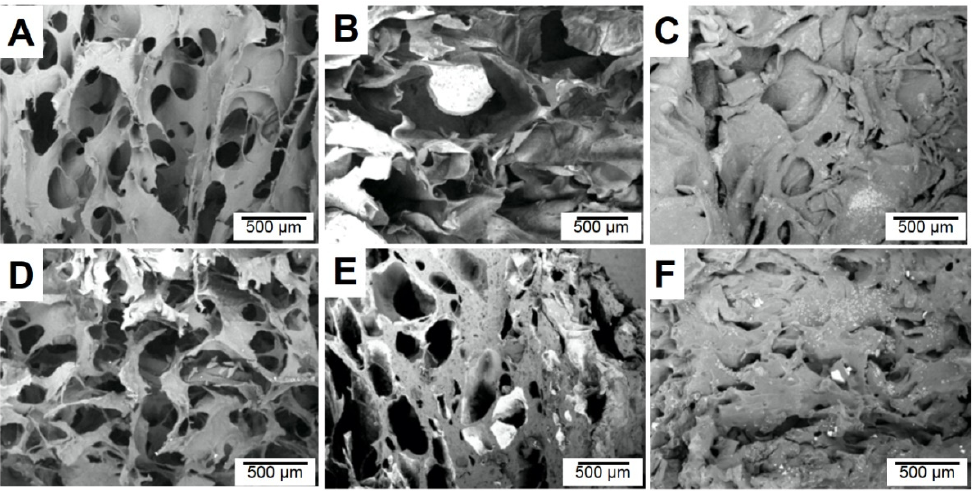
Figure 4. Microscope images of ( A ) MC; ( B ) CMC; ( C ) HEC cellulose and ( D ) MC-80/20; ( E ) CMC- 80/20; ( F ) HEC-80/20 cellulose/WPU composite aerogels.